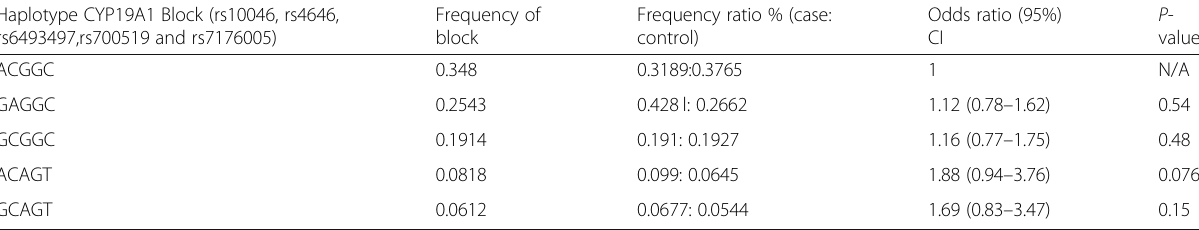
Global haplotype association p - value:0.066 N/A not